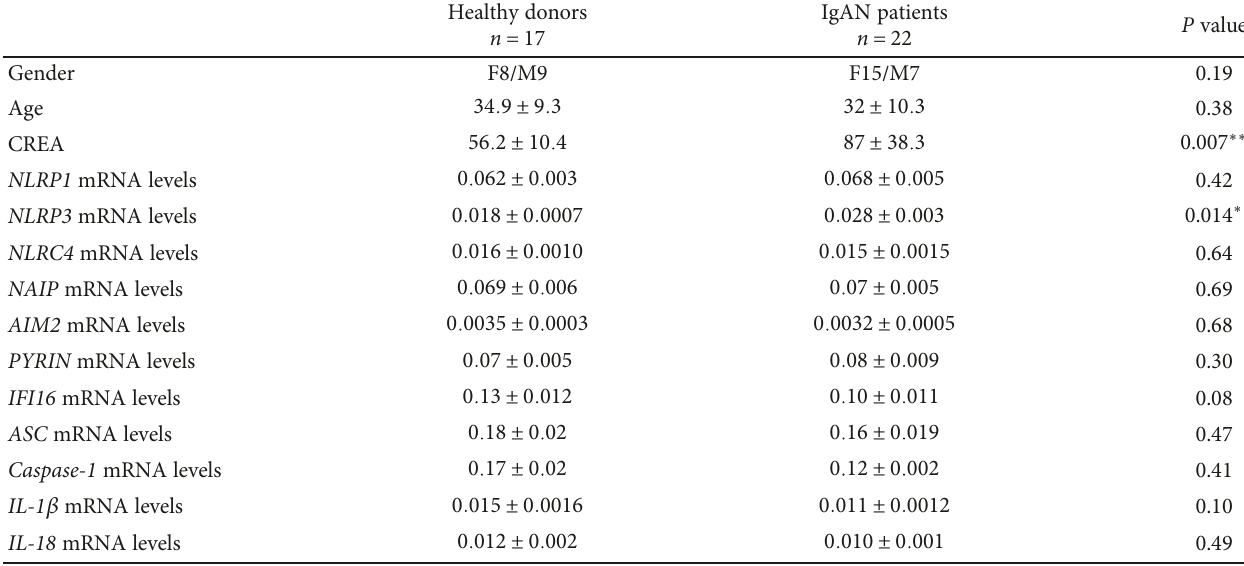
Table 2: Expression pro fi les of in fl ammasome members in PBMCs of IgAN